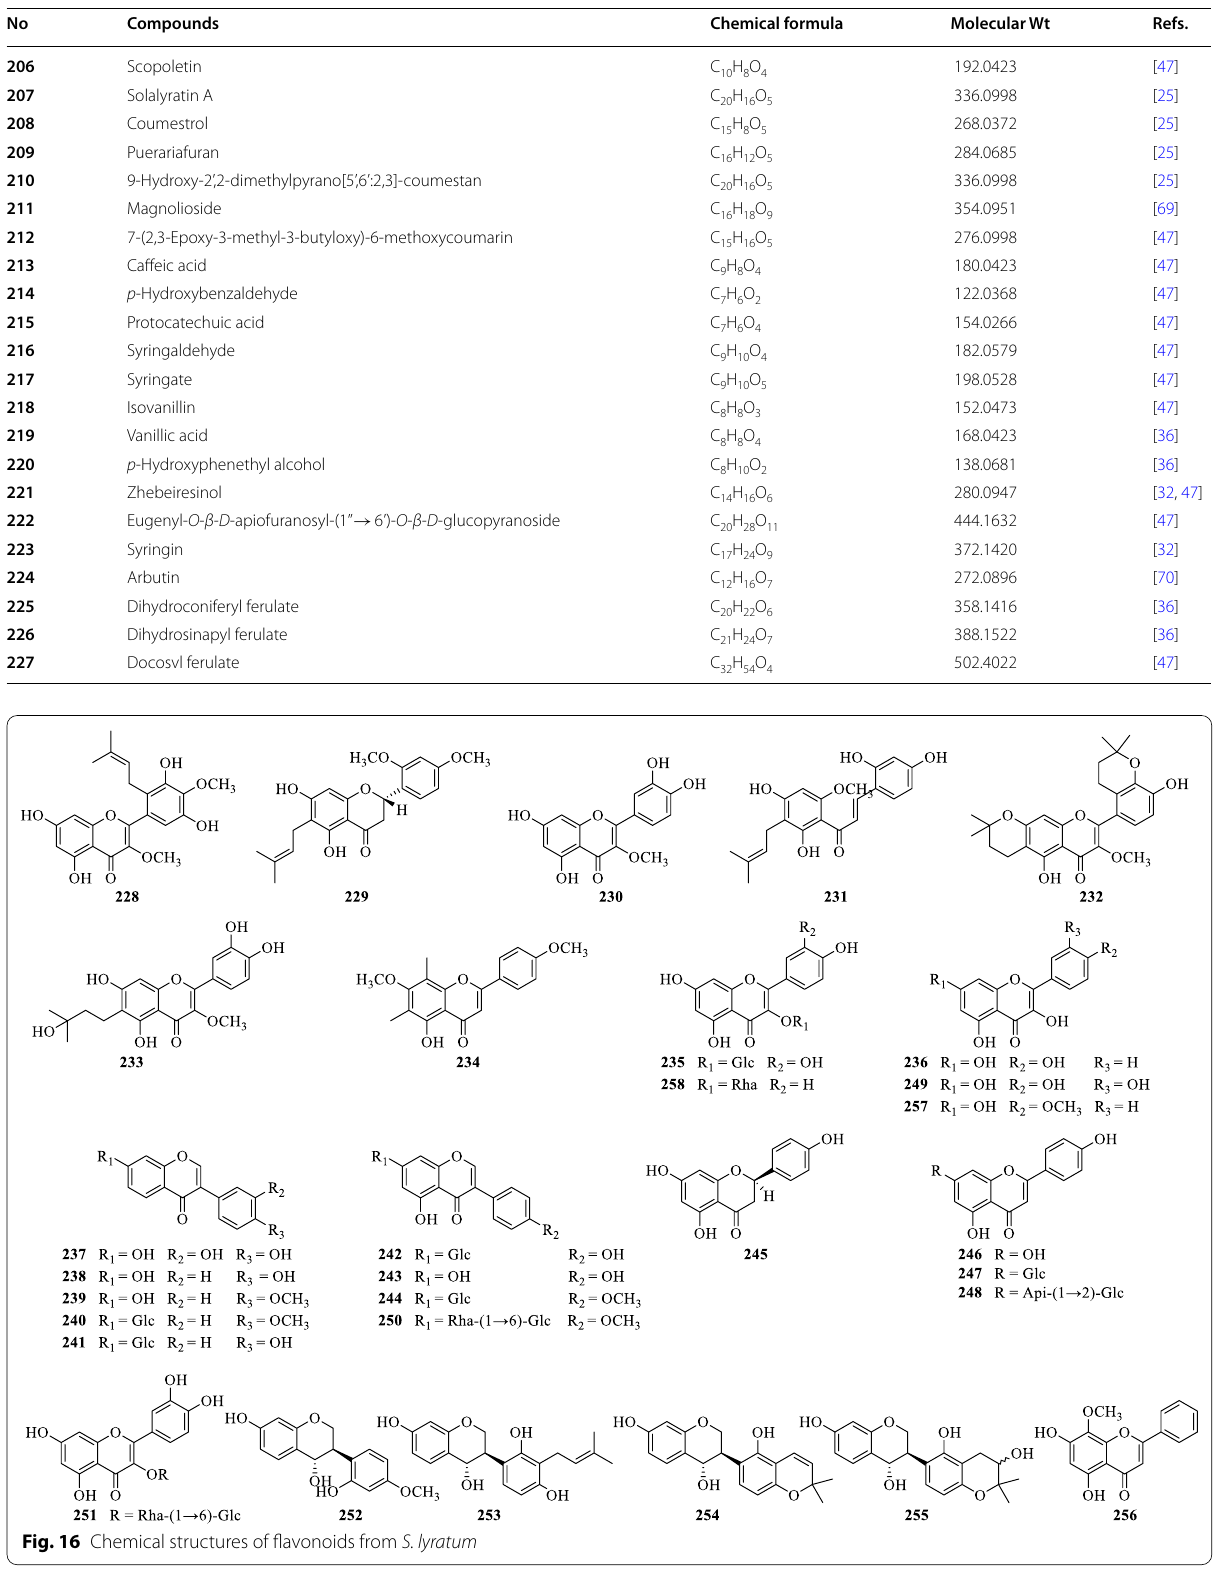
Fig. 16 Chemical structures of flavonoids from S.